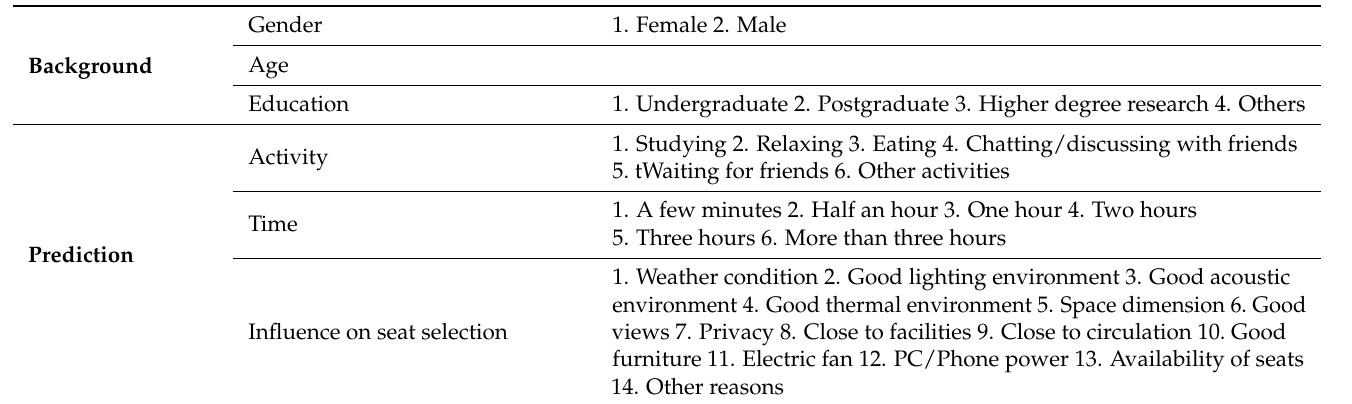
Table 2. Seating preference satisfaction